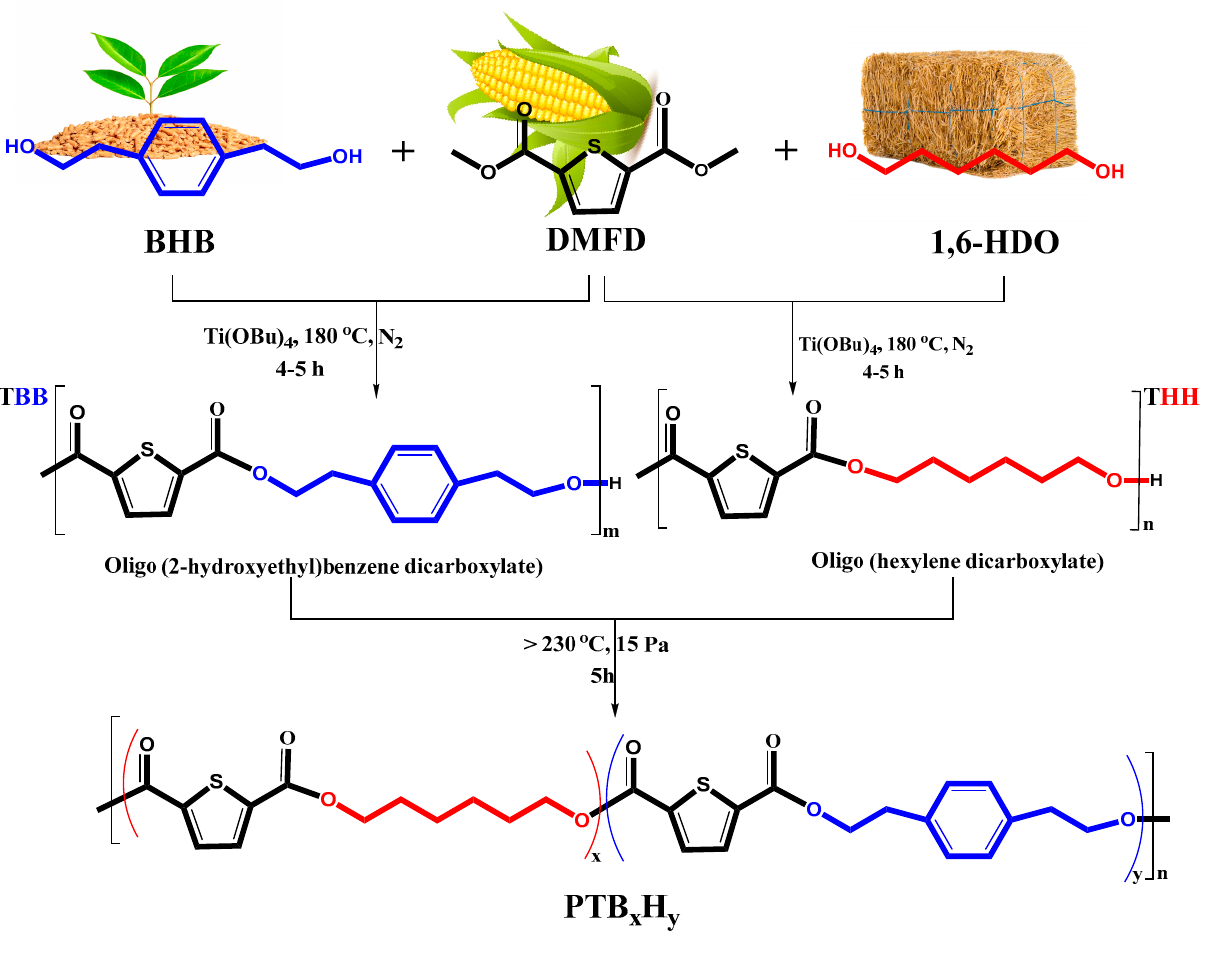
Figure 10. Synthetic route for poly(hexylene 2,5-thiophenedicarboxylate-co-bis(2- Figure 1. Synthetic route for poly(hexylene 2,5-thiophenedicarboxylate-co-bis(2- hydroxyethoxybenzene) (PTB x H y ) copolyesters. hydroxyethoxybenzene) (PTB x H y )